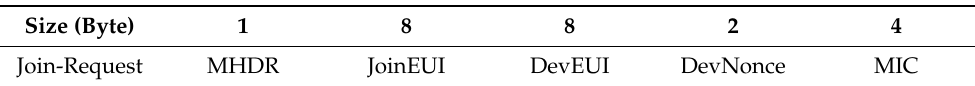
Table 2. Join-Request